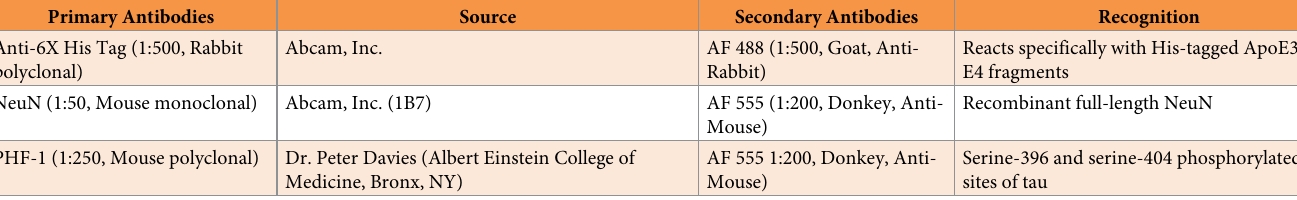
Table 1. Description of antibodies used for immunofluorescence